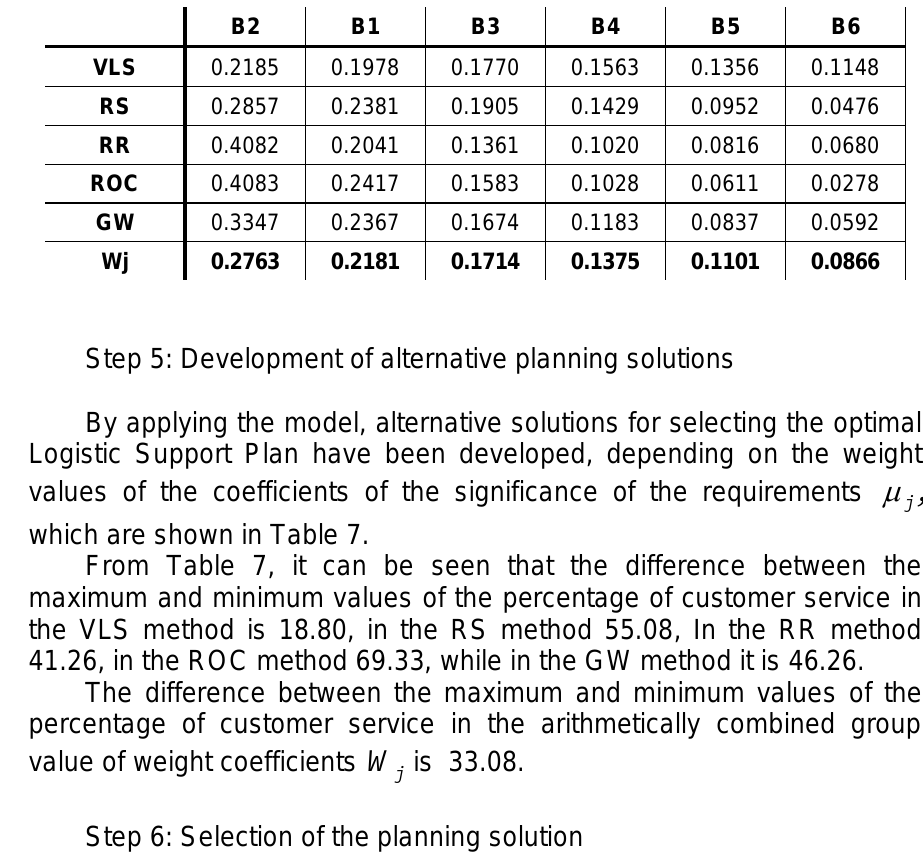
Table 6 – Weight values of the coefficient of significance of the request Tаблица 6 – Весовые значения коэффициента значимости запроса Табела 6 – Тежинске вредности коефицијената значајности